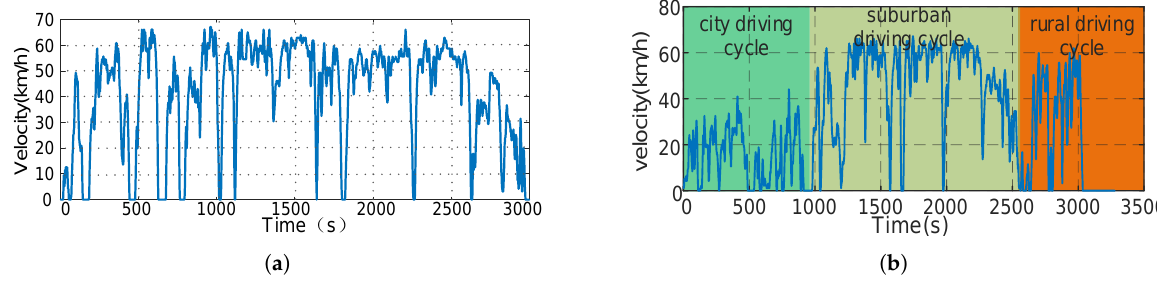
Figure 14. Testing driving cycle. ( a ) Real-world driving cycle c1. ( b ) Real-world driving cycle